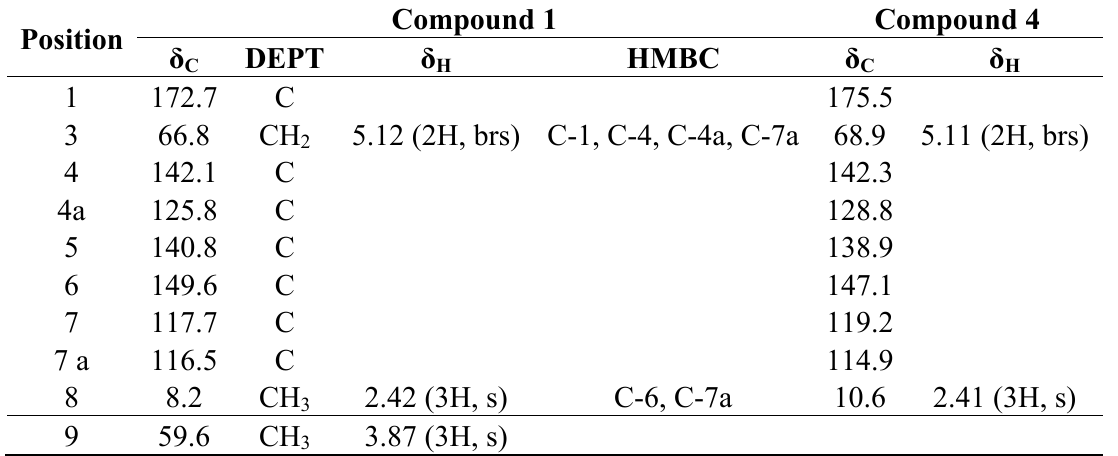
OD. ( 1 H at 400 and 13 C at 100 MHz; J in 3